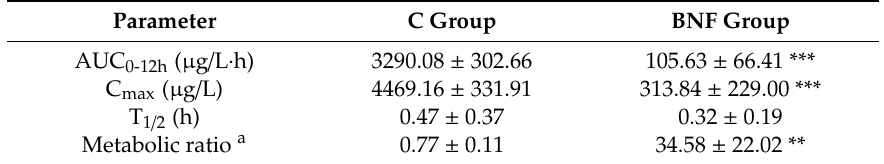
Table 2. Pharmacokinetic (PK) parameters after a single intragastric administration of phenacetin. Parameter C group